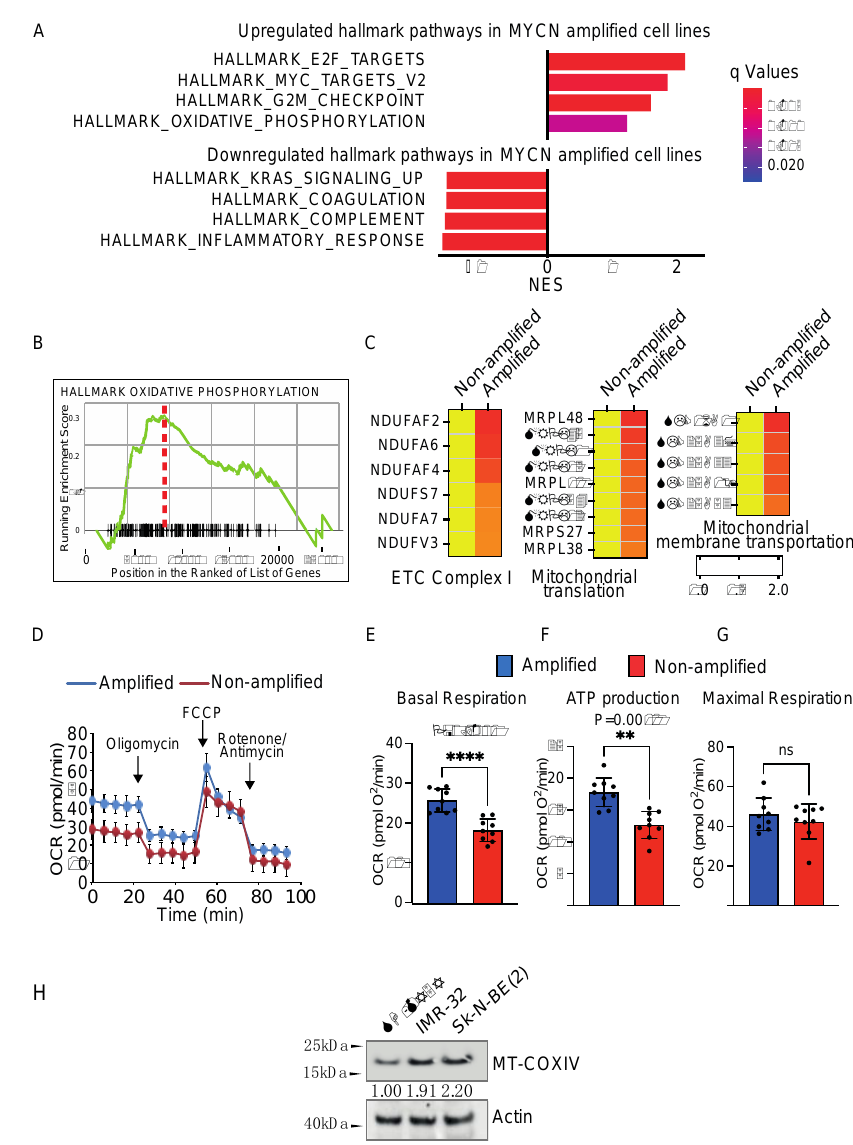
Figure 1. MYCN -amplified neuroblastoma cells upregulated the OXPHOS hallmark pathway and mitochondrial activity. ( A ) GSEA data analysis of RNA-SEQ from 39 neuroblastoma cell lines revealed that the OXPHOS (Oxidative phosphorylation) hallmark pathway is among the most upregulated pathways in MYCN -amplified neuroblastoma cells. NES: normalized enrichment scores. ( B ) Representative graph for enriched mitochondrial OXPHOS pathway ( p = 0.008 q = 0.011). ( C ) Genes coding for mitochondrial electron transport chains (ETC), components of mitochondrial translation and transportation machinery are upregulated in MYCN -amplified neuroblastoma cells. The full list of changes of mitochondrial genes is included in Supplementary Data S1. ( D ) Oxygen Consumption Rate (OCR) in MYCN -amplified Sk-N-BE(2) cells and non-amplified SH-SY5Y neuroblastoma cells. Oligomycin (1.5 µ M), FCCP (1.0 µ M), antimycin A (0.5 µ M), and rotenone (1.0 µ M). ( E – G ) Basal respi- ration, ATP-linked respiration and Maximal respiration analyzed from Figure 1D in MYCN -amplified and non-amplified neuroblastoma cells. Data are shown as mean ± SD, statistical analysis using two-tailed unpaired t -test. ** p < 0.01 and **** p < 0.0001 and ns: not significant. ( H ) Expression levels of mitochondrial mass marker MT-COXIV in neuroblastoma cells. Here, Sk-N-BE(2) and IMR-32 are MYCN -amplified cells and SH-SY5Y are MYCN -nonamplified cells. Actin is loading control.